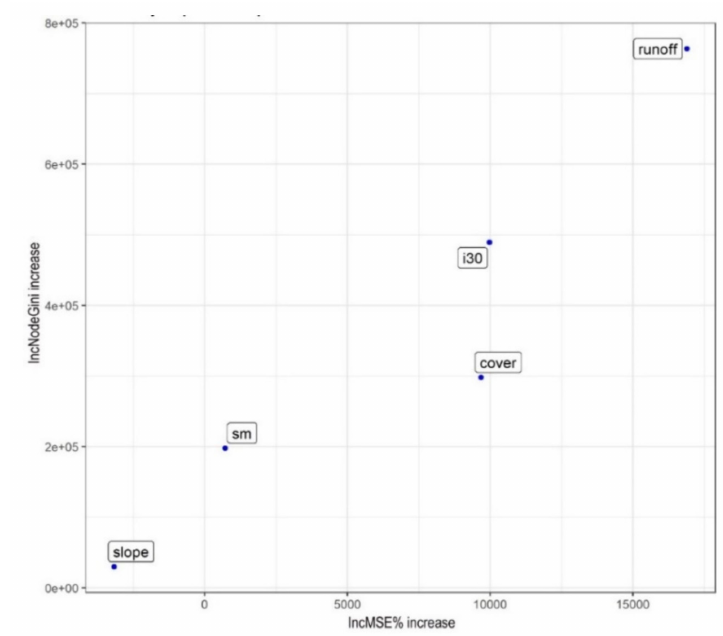
Figure 6. Evaluation metrics of random forest regression (RFR ((sm: soil moisture, slope: slope type, cover: soil cover, i30: rainfall amount in 30 min).